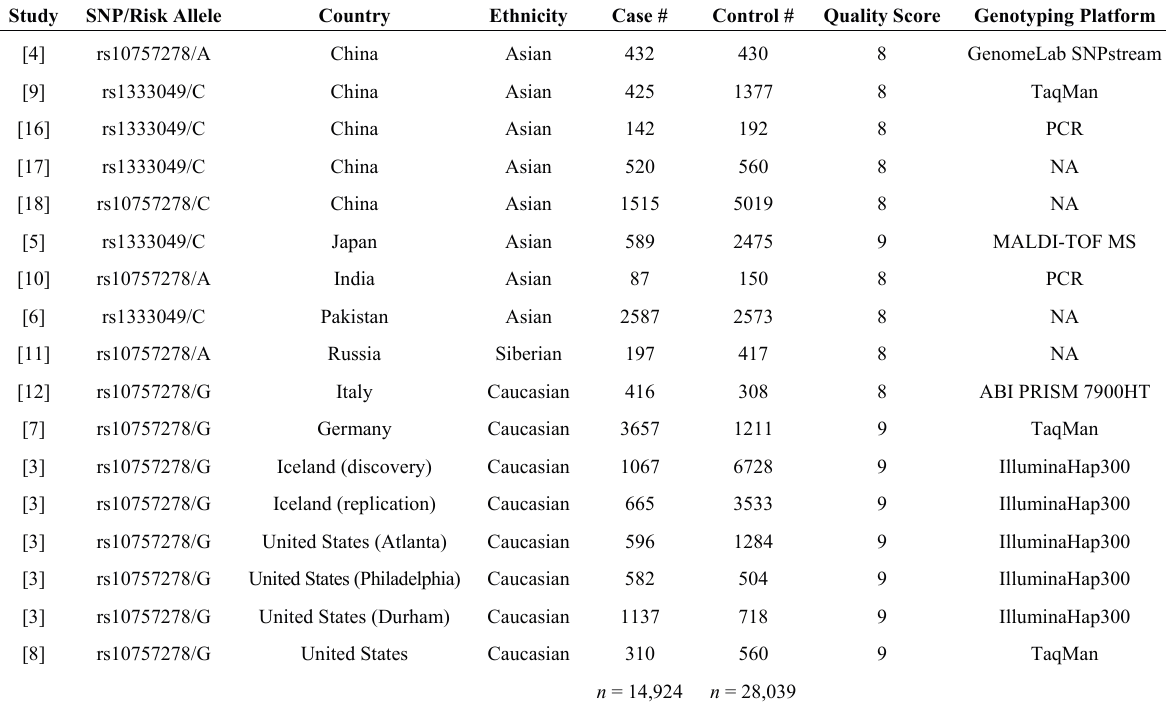
Figure 1. Flow chart of meta-analysis for exclusion or inclusion of individual articles. Table 1. The selected studies investigating the association between rs10757278 and Myocardial infarction